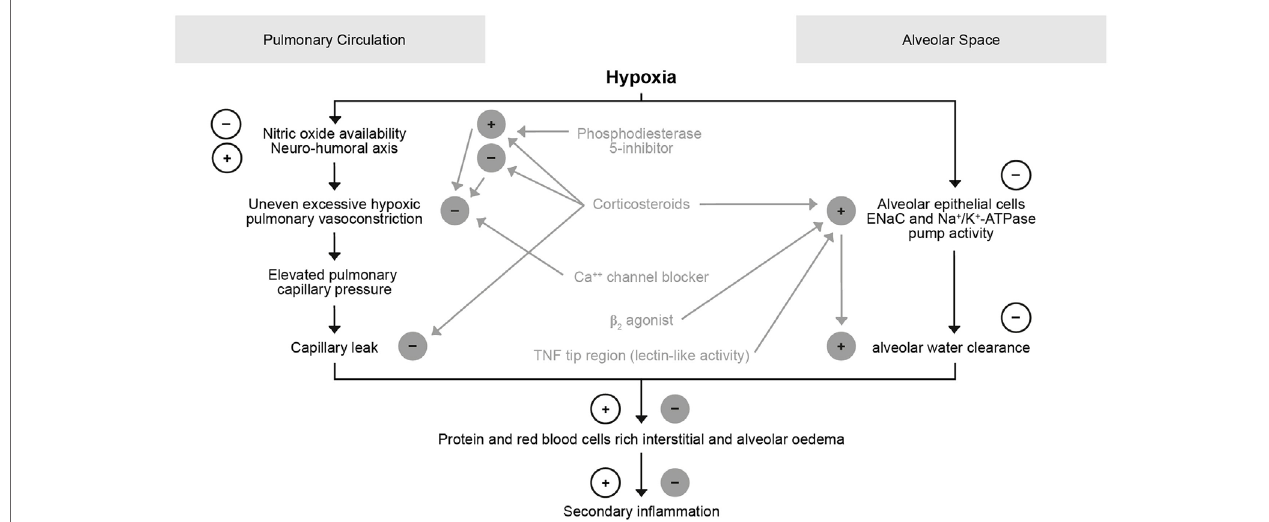
FigURe 6 | Role of hypoxia in the pulmonary circulation and alveolar